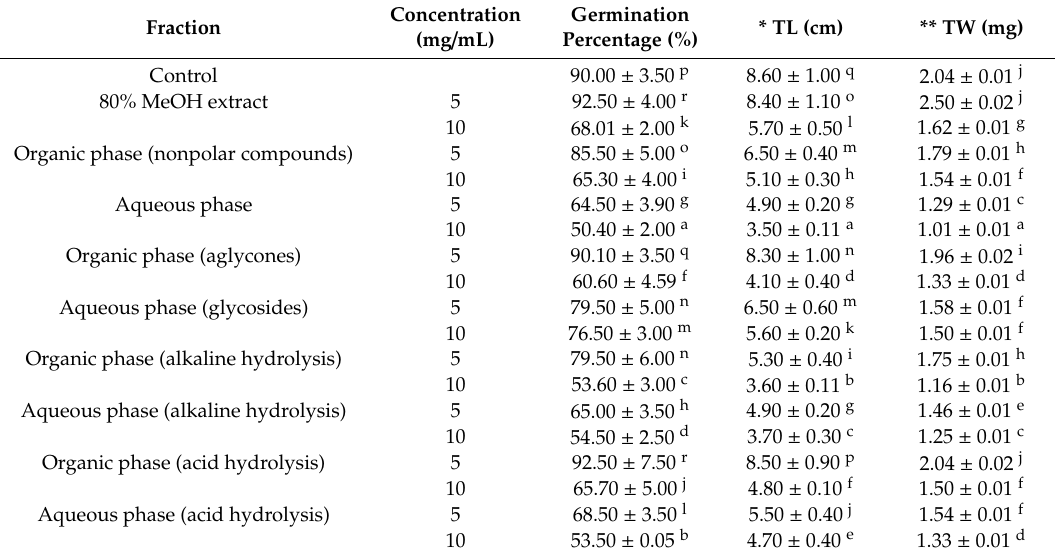
Table 4. E ff ect of various alfalfa leaf extract fractions on alfalfa seed germination.